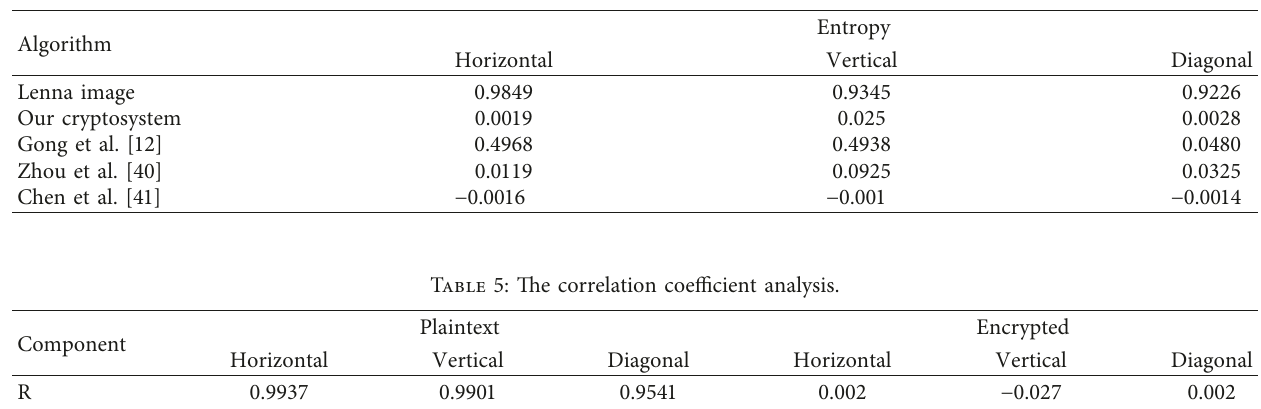
Table 4: The local Shannon entropy comparison tests.